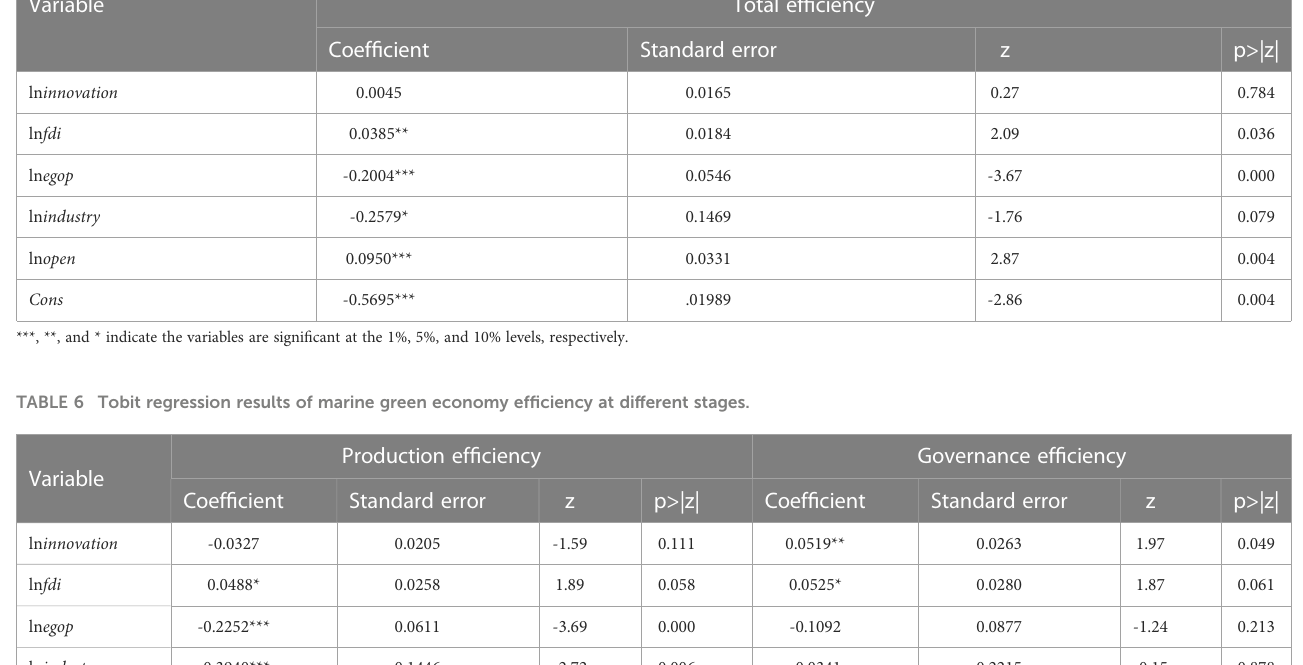
TABLE 5 Tobit regression results of marine green economy ef fi ciency. Variable